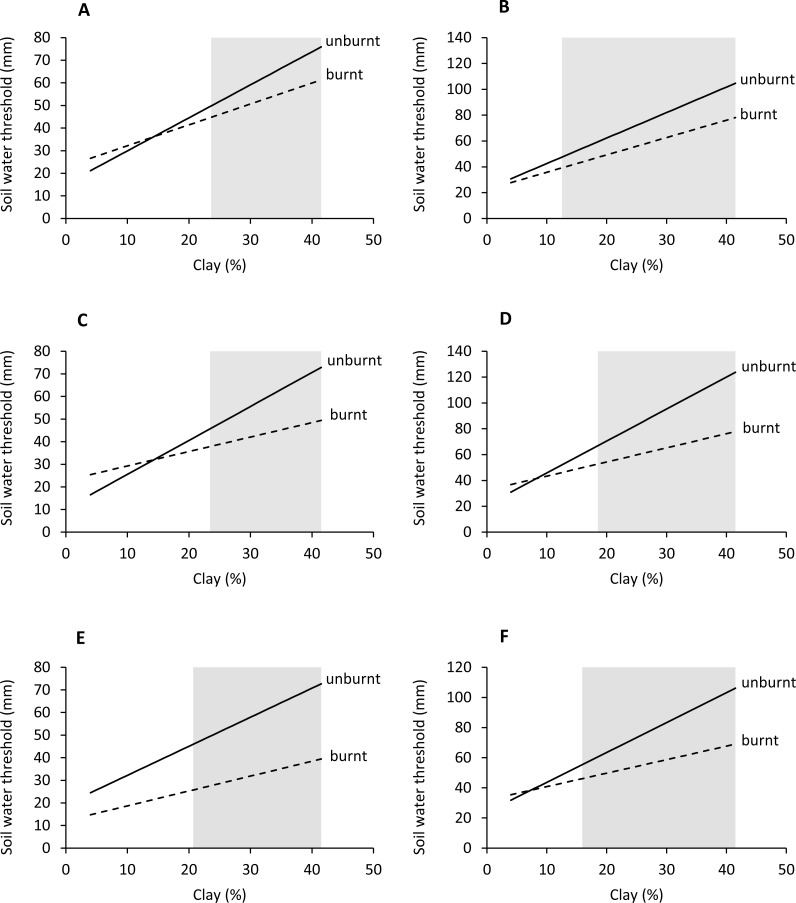
Effect of a significant interaction between soil clay content and fire (>5 months previously) on soil water thresholds for green grass, green forbs and mixed grass.Green grass M1 (A); green grass M2 (B); green forbs M1 (C); green forbs M2 (D); mixed grass M3 (E); mixed grass M4 (F). Regions of significant (P < 0.05) difference between burnt and unburnt areas are shaded grey.